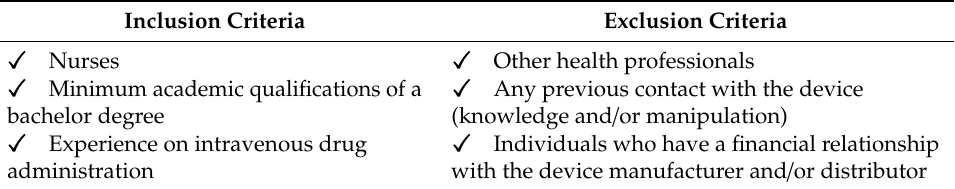
Table 1. Eligibility criteria for